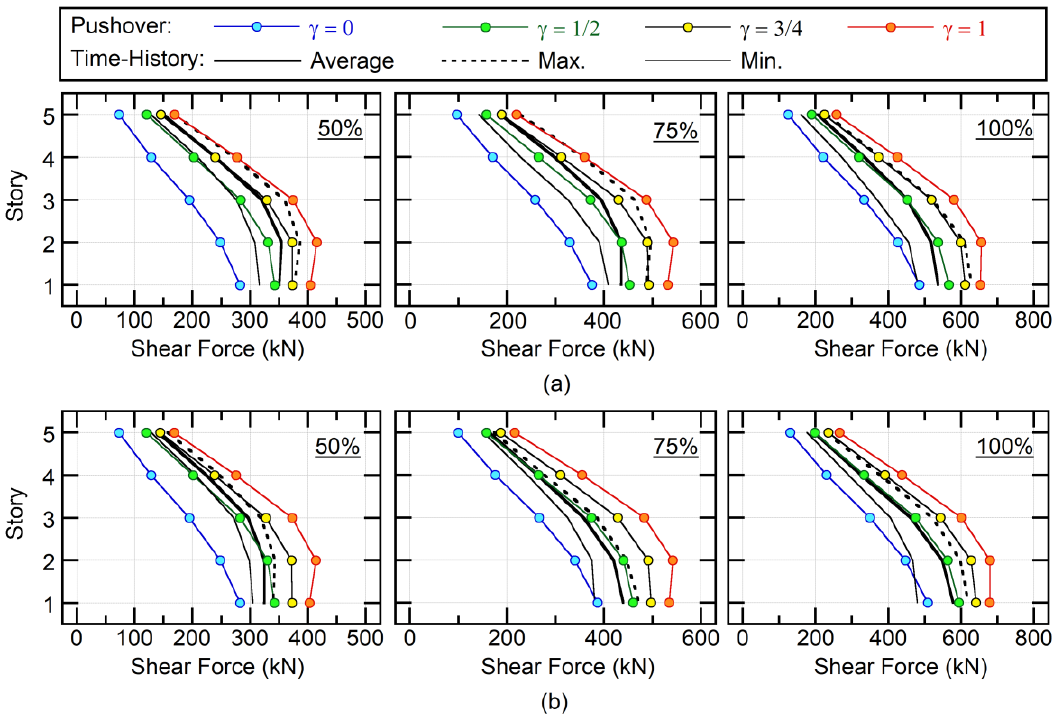
Figure 21. Comparison of the maximum shear force of column X 2 Y 2 in Model-05: ( a ) Art-S series and ( b ) Art-L series.